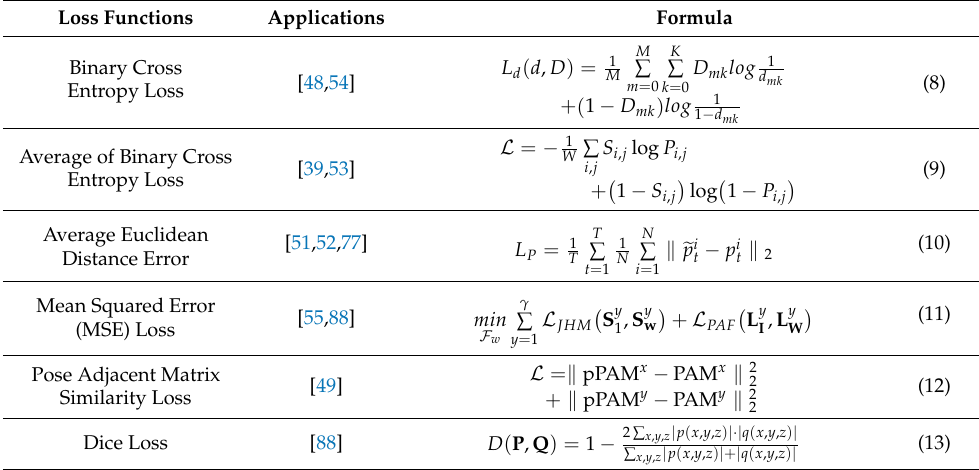
Table 4. Loss Functions